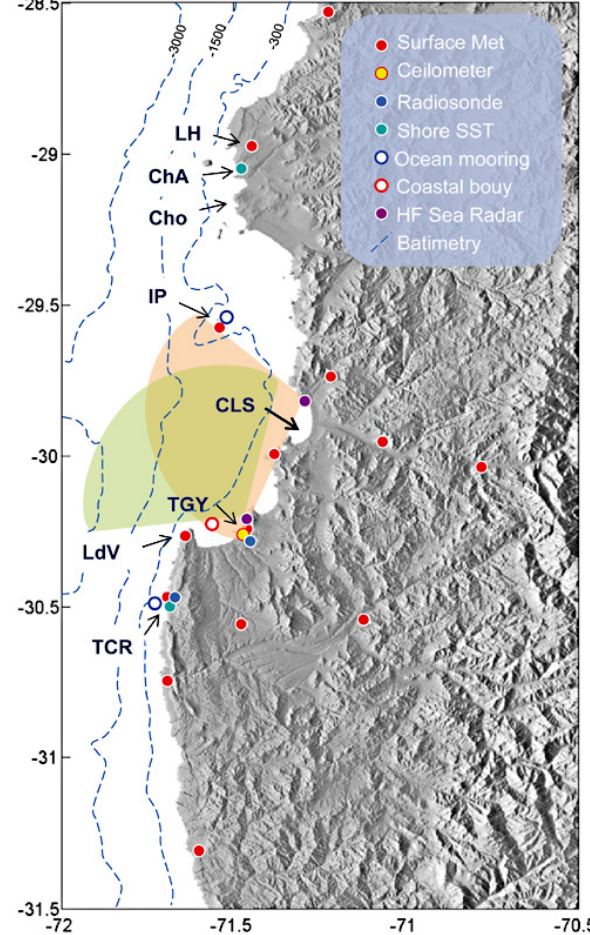
Fig. 2. Shaded relief of the coastal CUpEx area. Coastal moun- tains are about 500m high. Relevant locations are TCR=Talcaruca, LdV=point Lengua de Vaca, TGY=Tongoy (town), CLS: Co- quimo and La Serena cities, IP=Islote Pajaros, Cho=point Choros, ChA=Cha˜naral de Aceituno, LH=Loma de Hueso. Also shown is the location of the meteorological and oceanographic measurement systems (color code in the inset). The light orange and green sec- tors indicate the area covered by the HF Sea Radars at La Serena and Tongoy, respectively. Blue, dashed lines indicate ocean floor depth (in